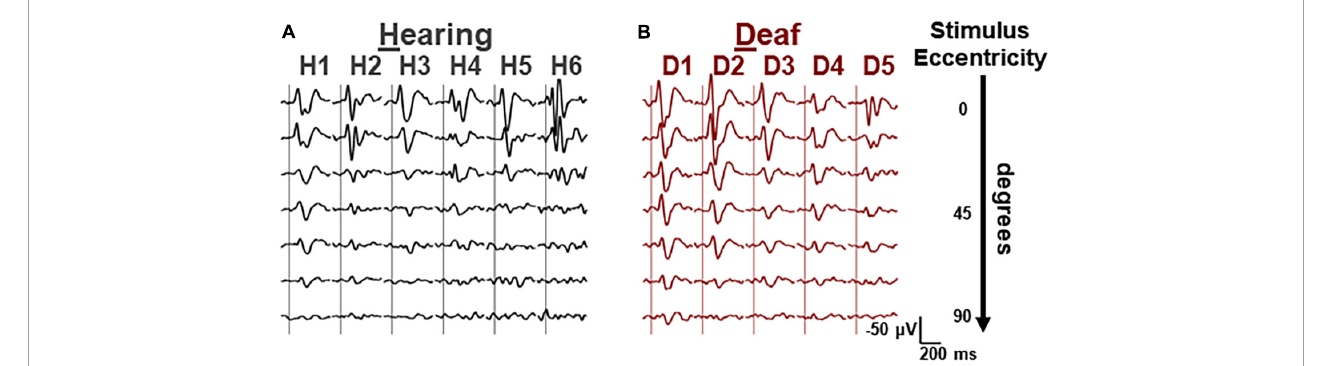
FIGURE2 Averaged VEP waveforms for different eccentricities of each subject. (A) Waveforms from the data collected from 6 hearing cats, grouped by subject and stacked in each column. Stimulus eccentricity increases for the waveforms from the top (central) to the bottom (90 deg). (B) Waveforms of 6 deaf cats. Same scalars are applied to both hearing and deaf waveforms. Horizontal, 200 ms. Vertical, 50 µ V, negative-up.